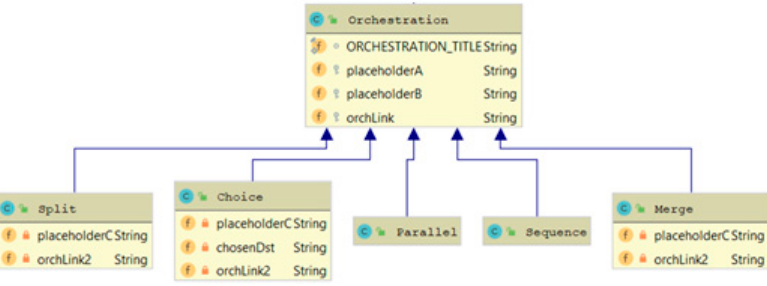
Figure 30. Descriptive overview of Orchestration class and its subclasses.